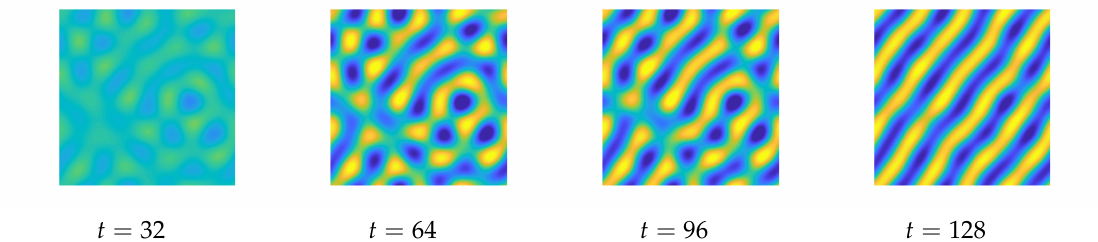
. In each snapshot, the yellow, green, 4 0.3420, respectively. −